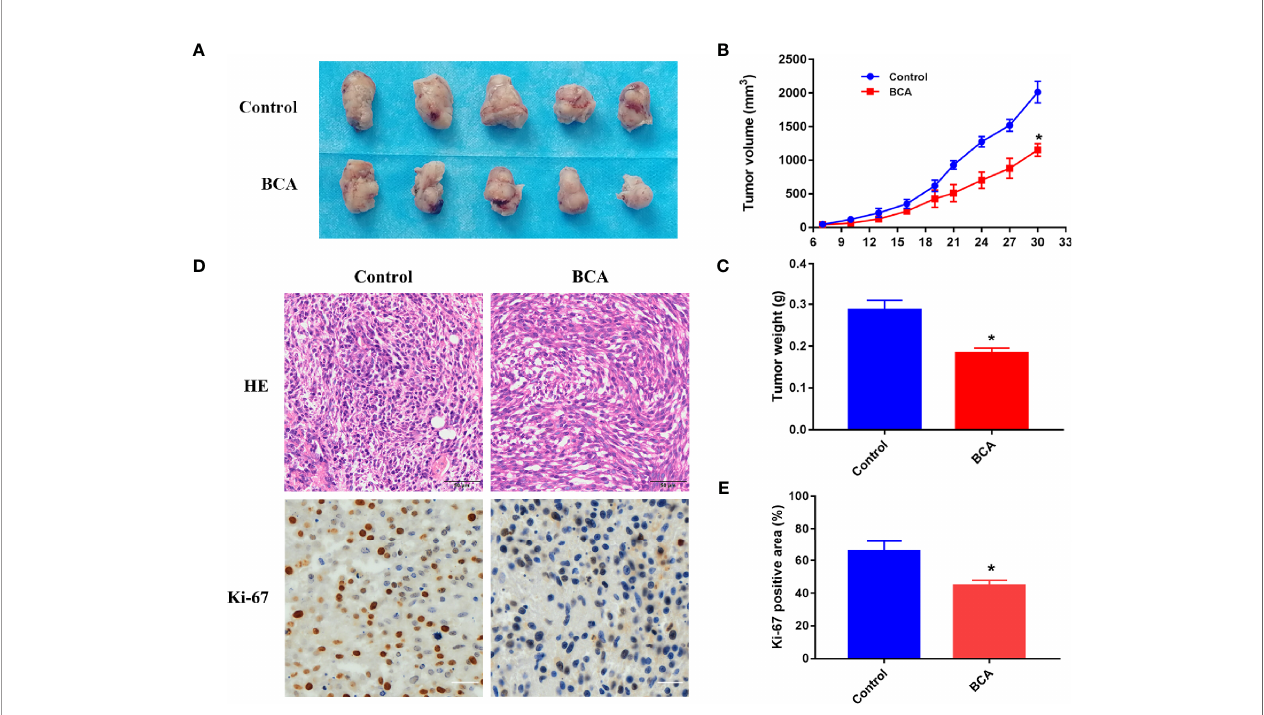
FIGURE 5 | BCA inhibits tumor growth in nude mice. (A) The tumor of control and BCA treatment group. (B) Tumor volumes of the control and BCA treatment group were measured and calculated every 3 days. (C) The tumor weight was measured in the control and BCA treatment groups. *P < 0.05, **P < 0.01 compared with control group. (D) H&E stained tumor xenograft tissues in control and BCA treatment and immunohistochemistry was used to detect the expression of Ki-67 in tumor xenograft tissues. (E) . Quanti fi cation of Ki-67 positive rate in the different treatment groups. *p < 0.05 vs. control